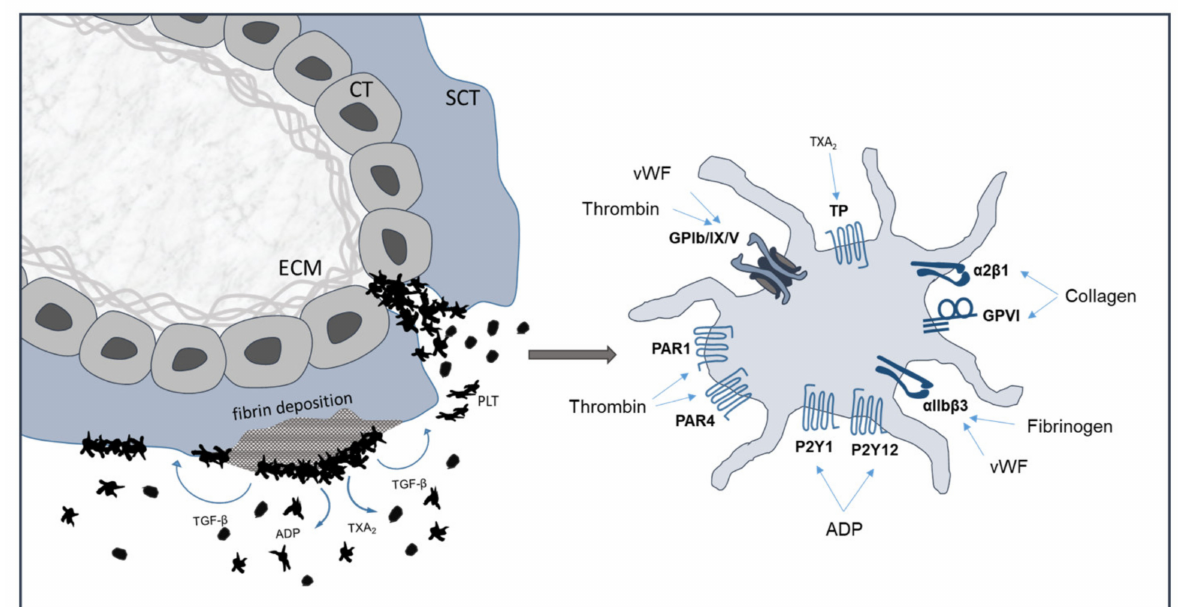
Figure 3. Platelet activation at the maternal-fetal interface. Scheme of a first trimester placental villus shows adherent platelets on fibrin deposition and on extracellular matrix on areas of disrupted villous trophoblasts. Activated platelet show relevant surface receptors. CT: cytotrophoblast; SCT: syncytiotrophoblast; ECM: extracellular matrix; PLT: platelet; TXA 2 : thromboxane A 2 ; ADP: adenosine diphosphate; TGF- β : transforming growth factor beta; vWF: von Willebrand factor; TP: thromboxane